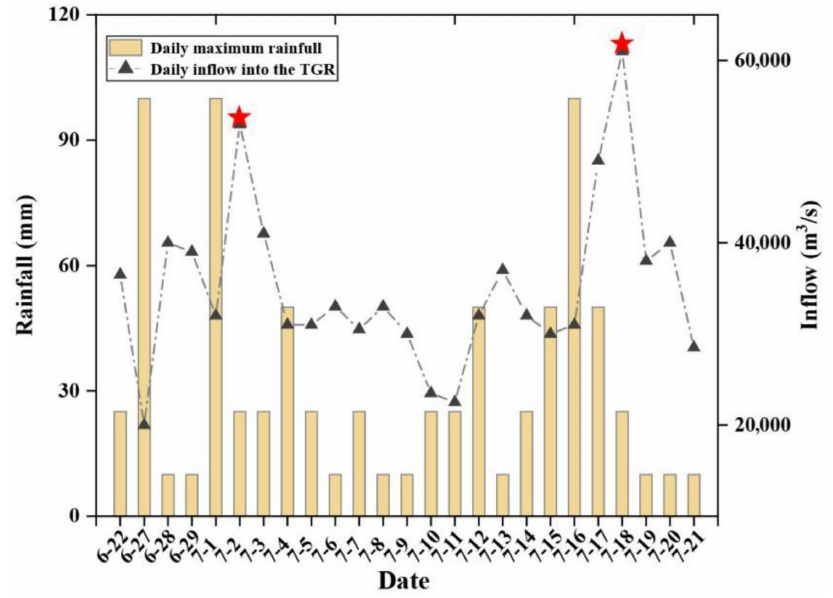
Figure 2. Daily maximum rainfall and inflow in the TGR during the sampling period. Red asterisks indicate the No. 1 and No. 2 floods of 2020, which have formed in the upper reaches of Changjiang River (from left to right). Data were collected from Changjiang River Hydrological Network